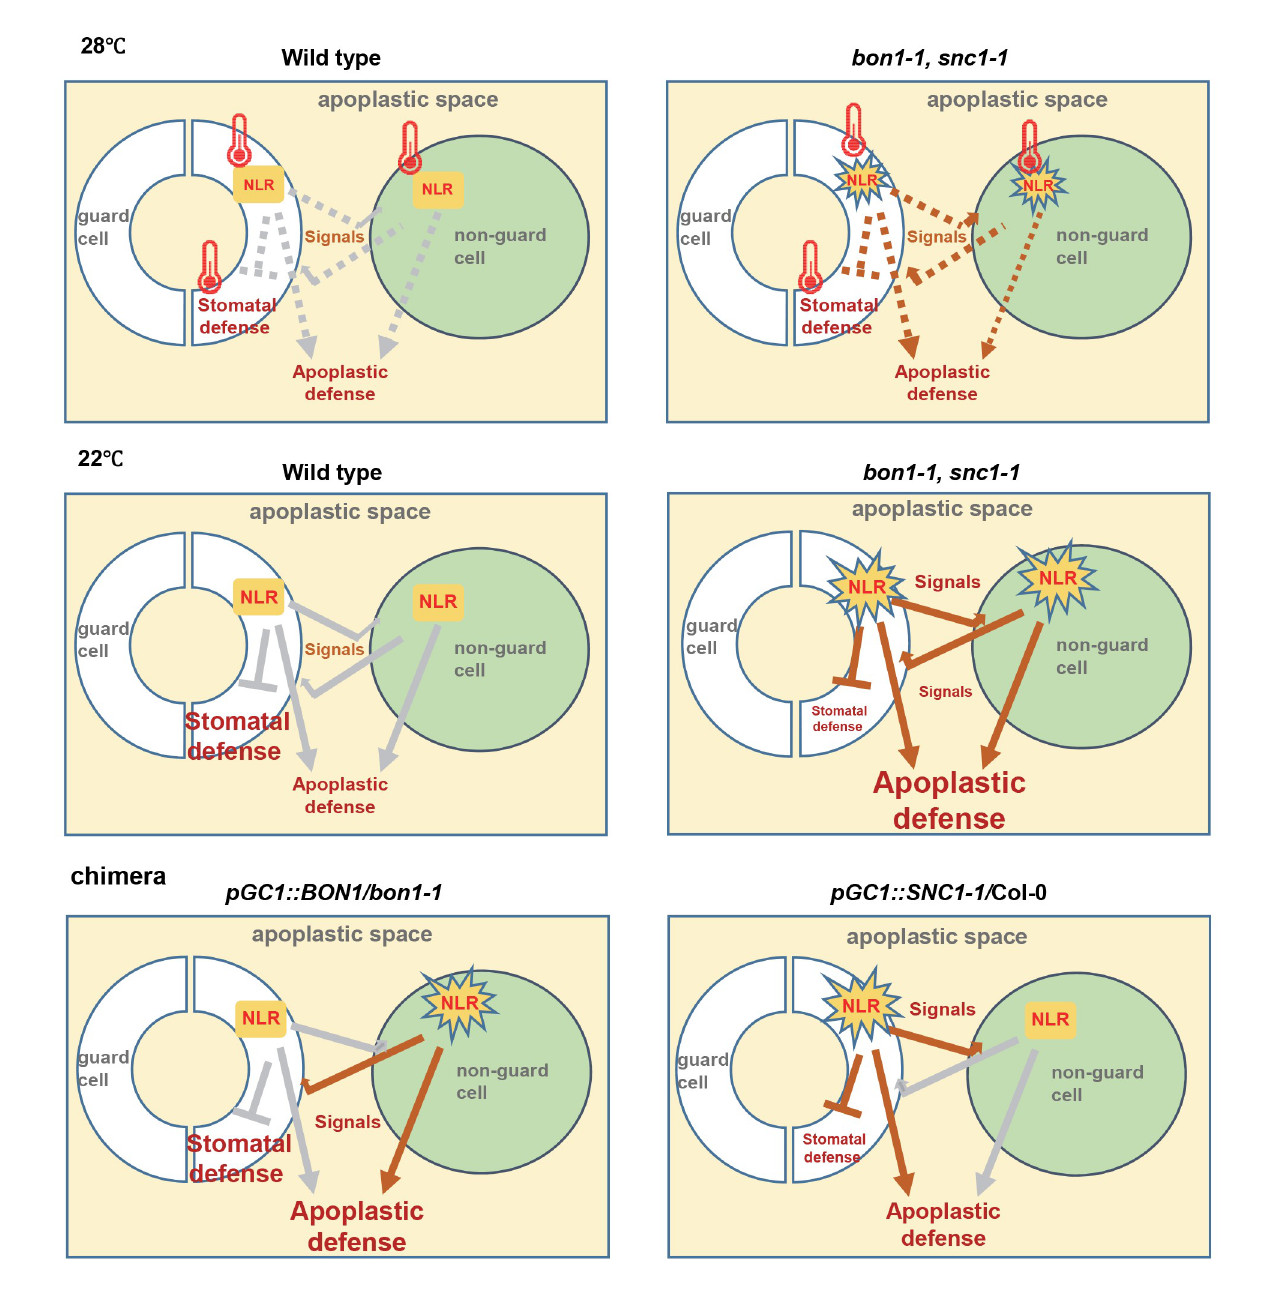
Fig 10. Working model of the connection between stomatal defense and apoplastic defense regulated by NLR genes. NLR activation inhibits stomatal defense in a cell autonomous manner and promotes apoplastic defense in a non-cell autonomous manner. Signals are generated by NLR activation to travel in apoplastic space to influence guard cells and non-guard cells. A higher temperature slows down stomatal defense and inhibits NLR activities independently. Diagrammed are stomatal defense and apoplastic defense in wild type, autoimmune mutants and chimera mutants at 22˚C and 28˚C. The size of letter indicates the strength/amplitude of the defense. Brown lines indicate strong action, gray lines indicate weak action, and dotted lines indicate no action. Thermometer sign indicates an inhibition from high temperature.